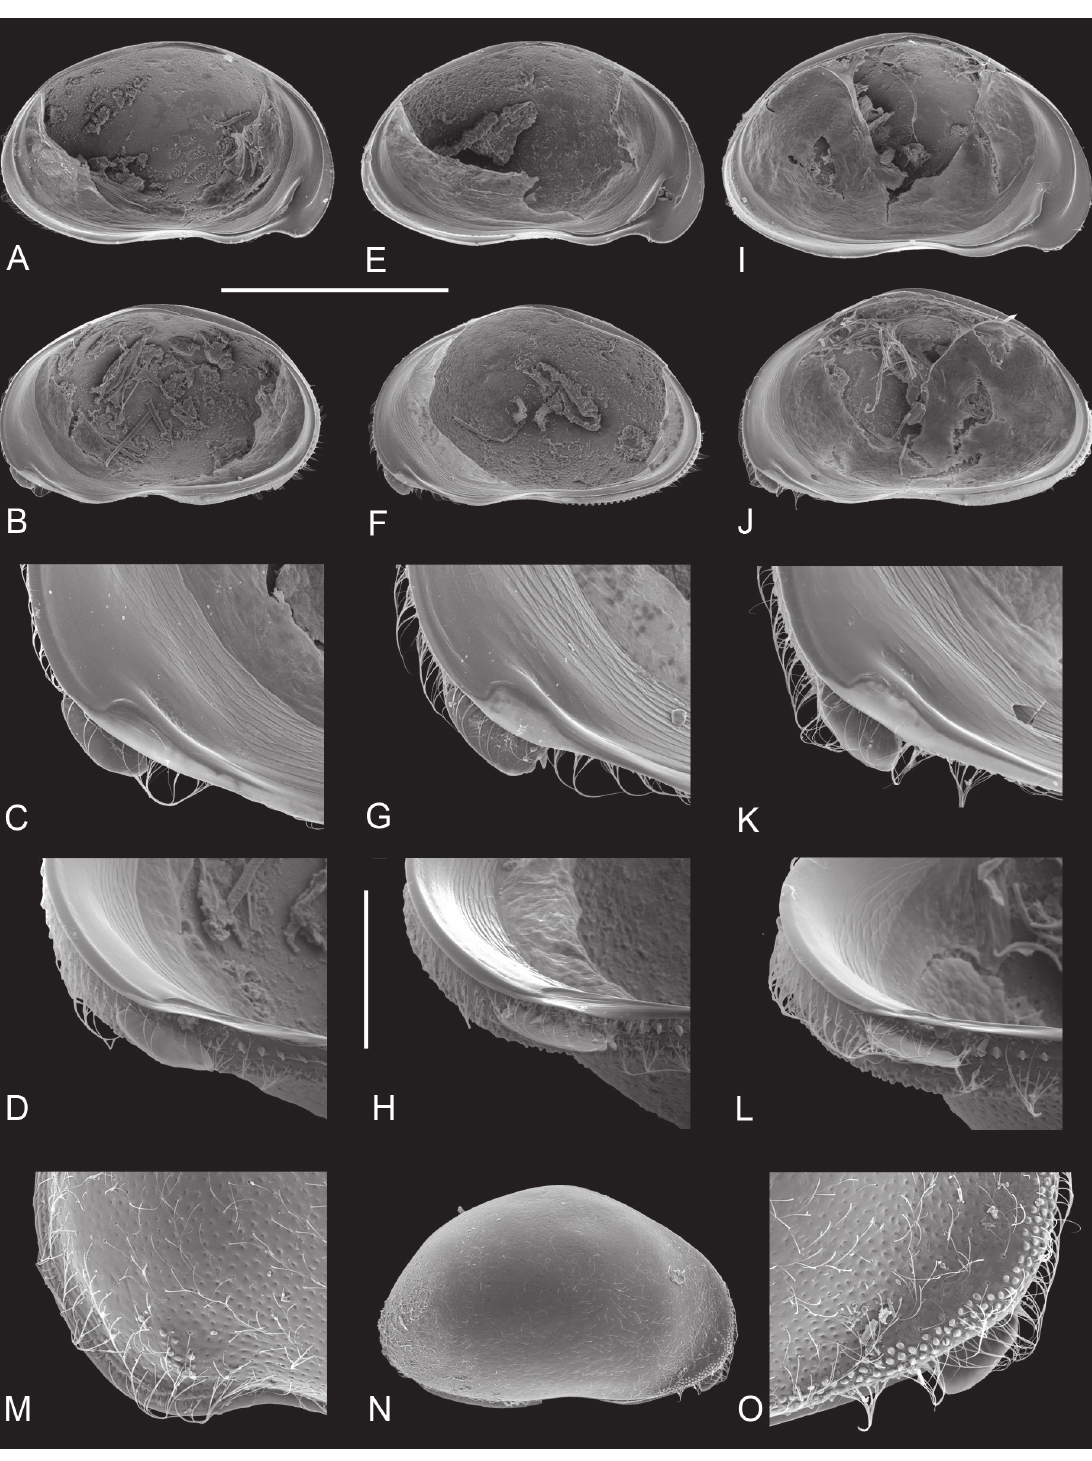
Fig. 19. Bennelongia scanloni sp. nov., non-type specimens. — A-D . Pool at latham-coorow rd (BVT/10/10, ♀, WAMC52307)). A . lVi. B . rVi. C . rVi, detail anterior. D . rVi, detail anterior, tilted. — E-H . Tin Dog Creek (DJC/19, ♀, OC.3335). E . lVi. F . rVi. G . rVi, detail anterior. H . rVi, detail anterior, tilted. — I-O . Pool at Brookton Hwy (Warrine Park) (DJC/23, ♀, OC.3337). I . lVi. J . rVi. K . rVi, detail anterior. L . rVi, detail anterior, tilted. M . lVe, detail anterior. N . rVe. O . rVe, detail anterior. scales: a-B, e-F, I-J, n = 1 mm; c-D, G-H, K-M, O = 200